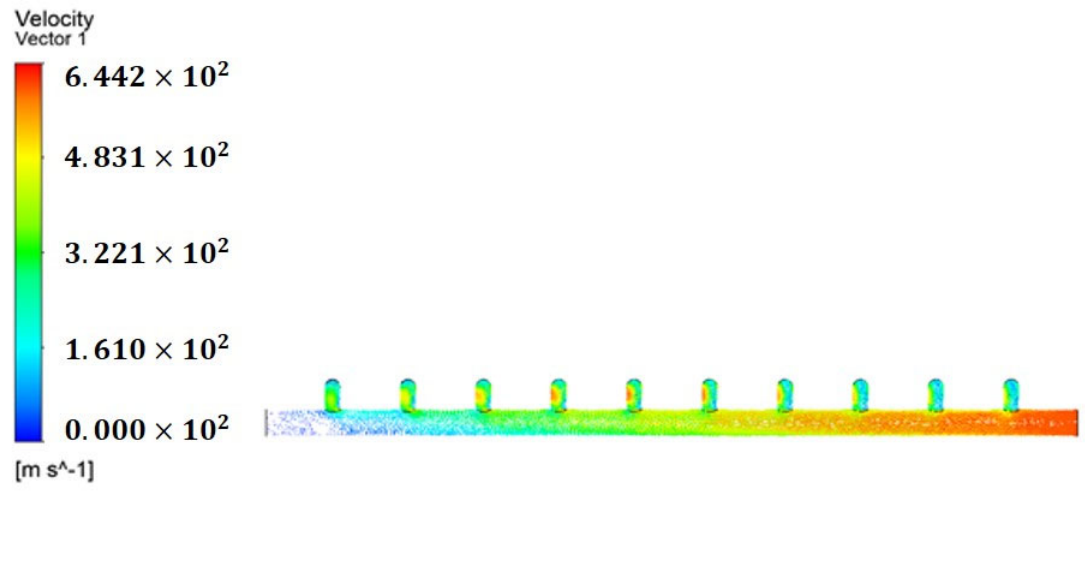
Figure 7. CFD simulation results for actual manifold pipe. ( a ) Velocity contour; ( b ) Velocity vector.